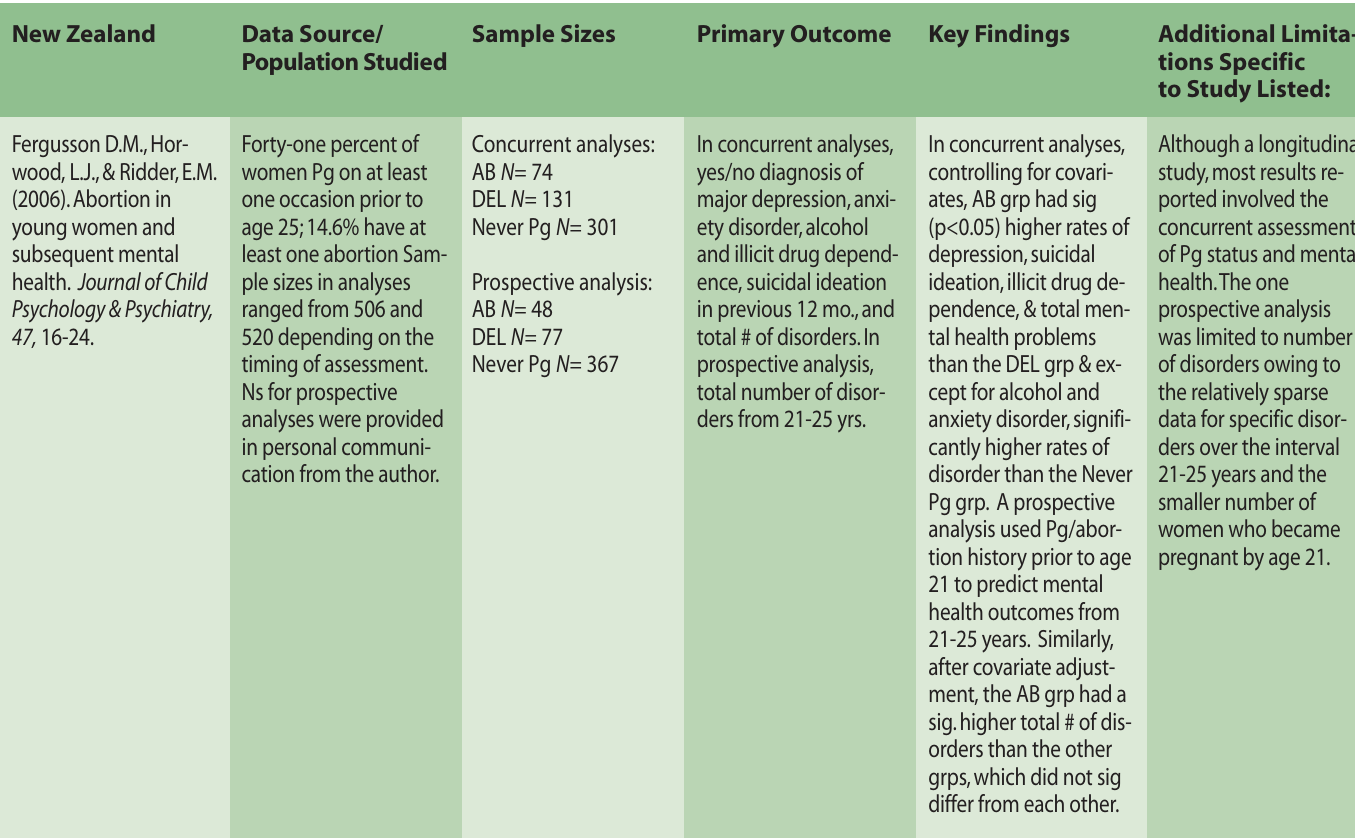
Table 1B: Secondary Analyses of Survey Data–Abortion vs.Comparison Groups INTERNATIONAL STUDIES–NEW ZEALAND Christchurch Health and Development